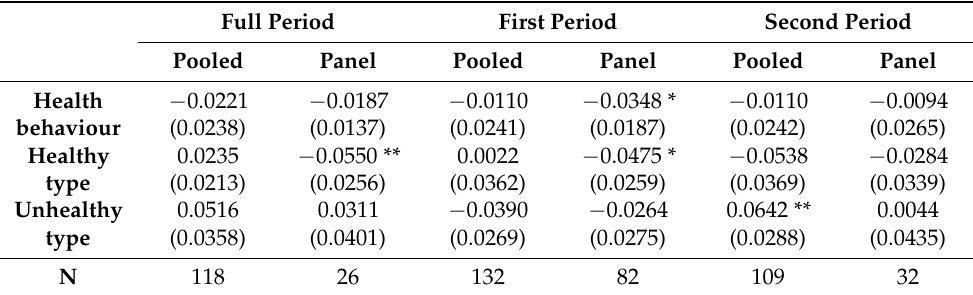
Table 4. The impact of the interventions.